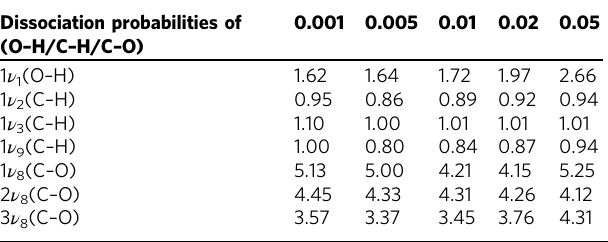
Table 1 Calculated vibrational ef fi cacies with respect to the overall reactivity of these in fl uential vibrational modes in the O – H/C – H/C – O dissociation Dissociation probabilities of (O – H/C – H/C – O)